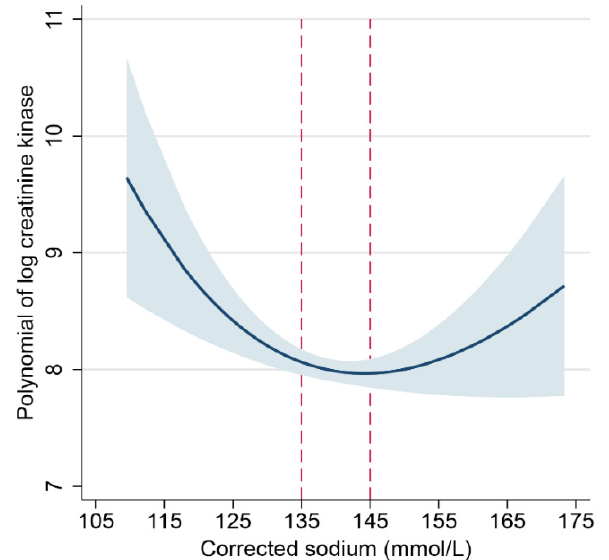
Figure 3. Regression of creatine kinase on sodium using fractional polynomials (blue line) with 95% confidence intervals (blue-gray band). The best-fitting relationship was U-shaped, suggesting that hypo- or hypernatremia was associated with higher creatine kinase, but a steeper left side suggested a larger effect of severe hyponatremia. Values in between the dashed red lines represent normal sodium levels (reference range).